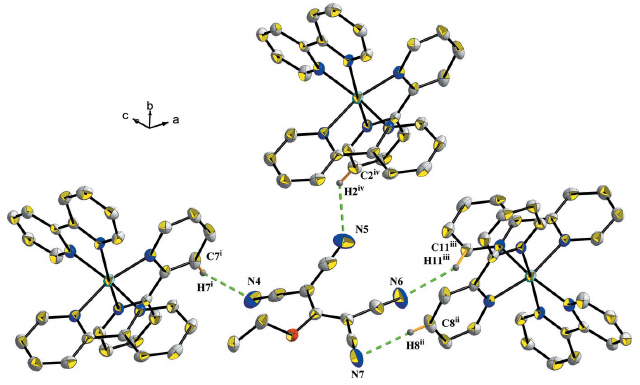
Figure 4 The hydrogen-bonding environment of the anion in compound (I). Only H atoms involved in hydrogen bonding have been included. [Symmetry codes: (i) 1 (cid:3) x , 1 (cid:3) y , 1 (cid:3) z ; (ii) 1